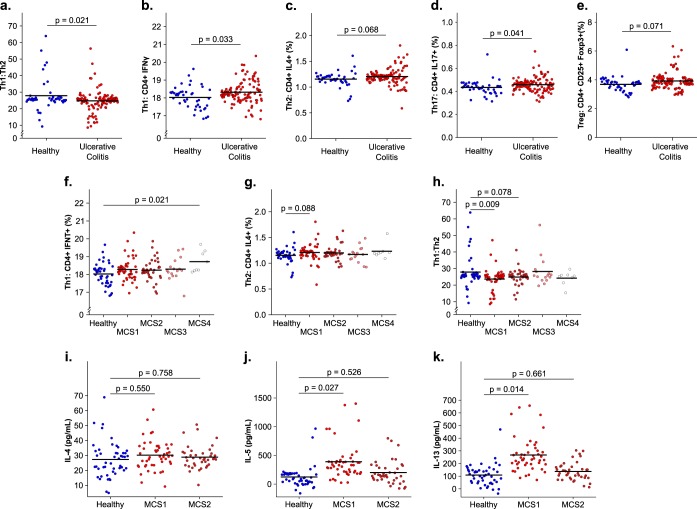
In vitro human T-cell activity following coculture with autologous DCs coincubated with sterile fecal water. Panels: a, Th1-to-Th2 ratio; b, Th1 frequency; c, Th2 frequency; d, Th17 frequency; e, regulatory T-cell frequency (48 healthy, 116 UC). Comparisons of the Th1 frequencies (f), Th2 frequencies (g), and Th1-to-Th2 ratios (h) of healthy and UC MCSs are shown (48 for healthy, 48 for MCS1, 40 for MCS2, 16 for MCS3, and 8 for MCS4). Concentrations of IL-4 (i), IL-5 (j), and IL-13 (k) in cell supernatant following coculture of human T cells with autologous DCs challenged with sterilized fecal water from healthy participants and MCS1 and MCS2 patients are shown (48 for healthy participants, 48 for MCS1 patients, and 40 for MCS2 patients). Data were generated from four (a to h) or two (i to k) replicate experiments with DCs/T cells obtained from two anonymous PBMC donors. Horizontal bars (mean fitted values for each group) and P values were determined by linear mixed-effect modeling (see Materials and Methods). P values of <0.1 are indicated.